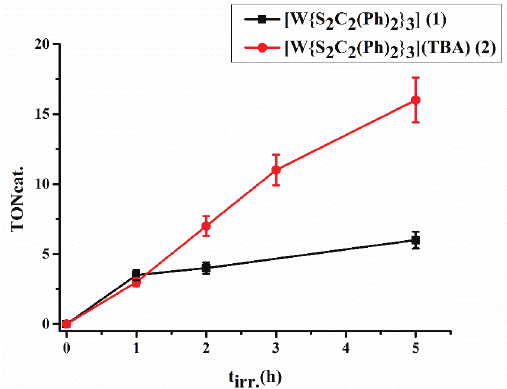
Figure 7: Hydrogen evolution with catalyst 1 (black) or catalyst 2 (red) 64μΜ/ [ReBr(CO) bpy] 0.25mM/ TEOA 1M/ AcOH 0.1M in 3 acetone, after 0-24h irradiation.